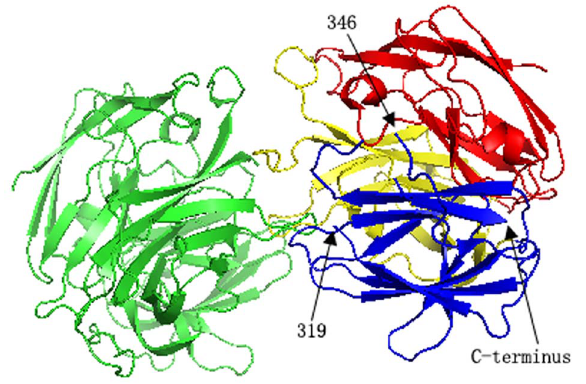
Figure 2. The carton illustration of the crystal structure of C- terminally His-tagged Lac15 (PDB No. 4F7K). The structure is composed of a homogenous dimer, in which one molecule is shown in green, and the three cupredoxin-like domain of the other are shown in red, yellow and blue respectively. The arrows point to the start and the end of the longest invisible region and the visible C-terminus of the protein structure (the last but one residue of Lac15 sequence connected with the